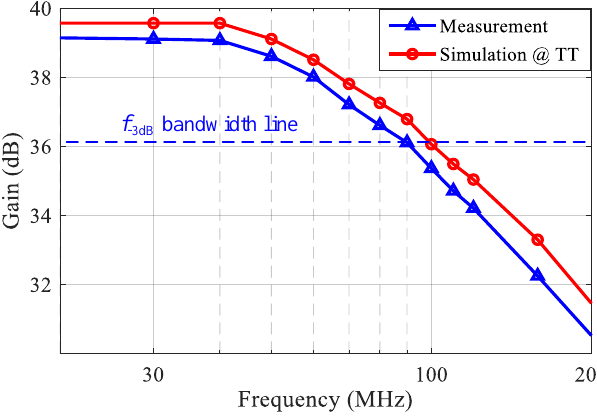
Figure 18. The measured frequency response of the front-end.